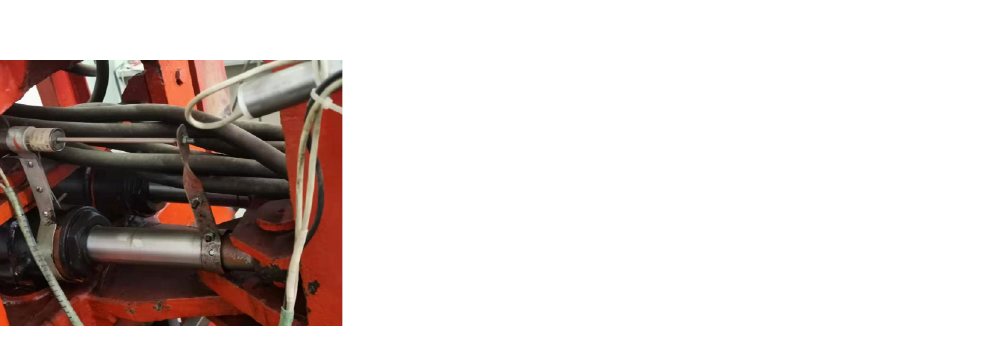
Figure 2. Swing DOF in the construction